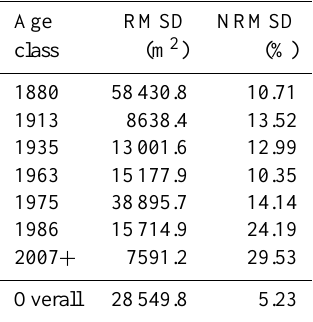
Table 5. Root mean square deviations (RMSDs) of the areas per grid cell compared with the areas obtained by assuming the fraction distribution at municipality level. NRMSD indicates the normalized